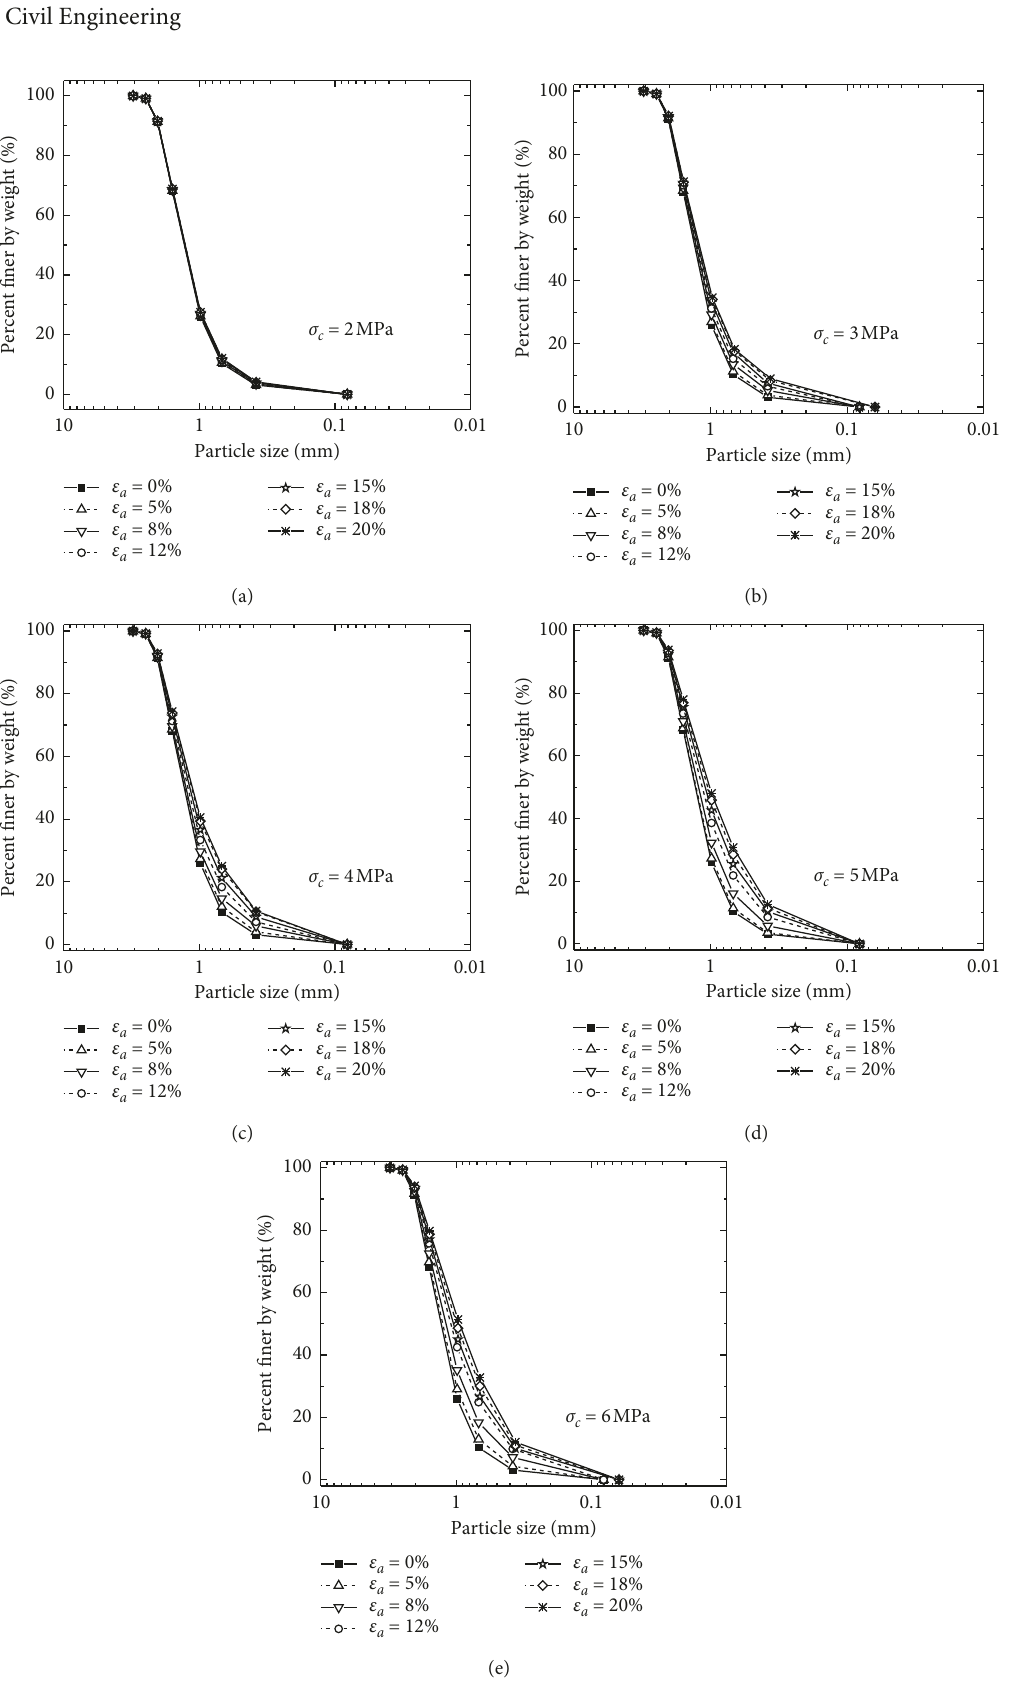
� 2MPa. (b) σ � 3MPa. (c) σ � 4MPa. (d) c c c